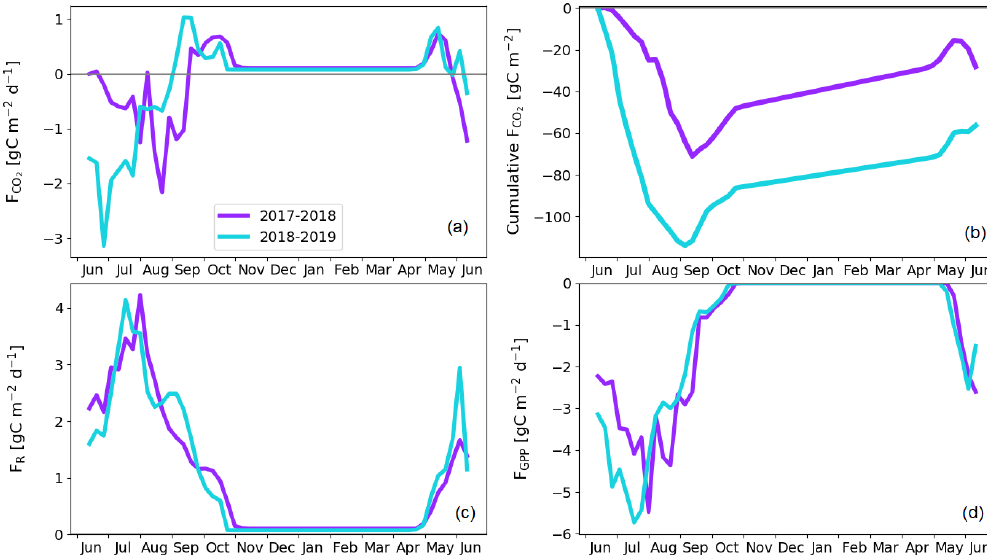
Figure A2. String top gap-filled fluxes. Weekly averaged (a) and cumulative CO 2 flux (b) and weekly averaged ER (c) and GPP (d) flux, which is used for estimating pine bog ecosystem